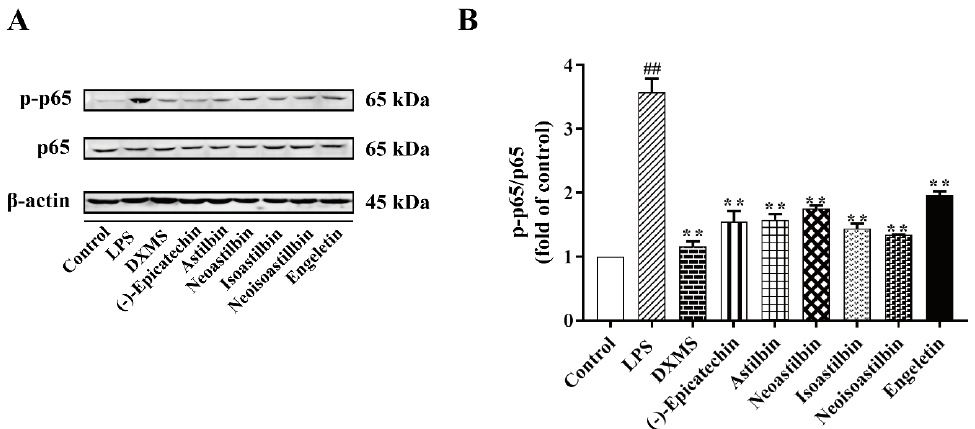
Figure 6. Effects of six flavonoids in Smilax glabra flavonoids extract (SGF) on the expression of NF- κ B p-p65 in RAW 264.7 cells. DXMS (dexamethasone) as positive control. RAW 264.7 cells were stimulated by LPS (1 μ g/mL) for 6 hours, then treated with six flavonoids (100 μ M) or DXMS (5 μ M). ( A ) The protein expressions of NF- κ B p-p65 and p65 detected by Western blotting. ( B ) The ratio of protein expression of NF- κ B p-p65/p65. Data are expressed as means ± SD ( n = 3). ## p < 0.01, compared with control group; ** p < 0.01, compared with LPS group.